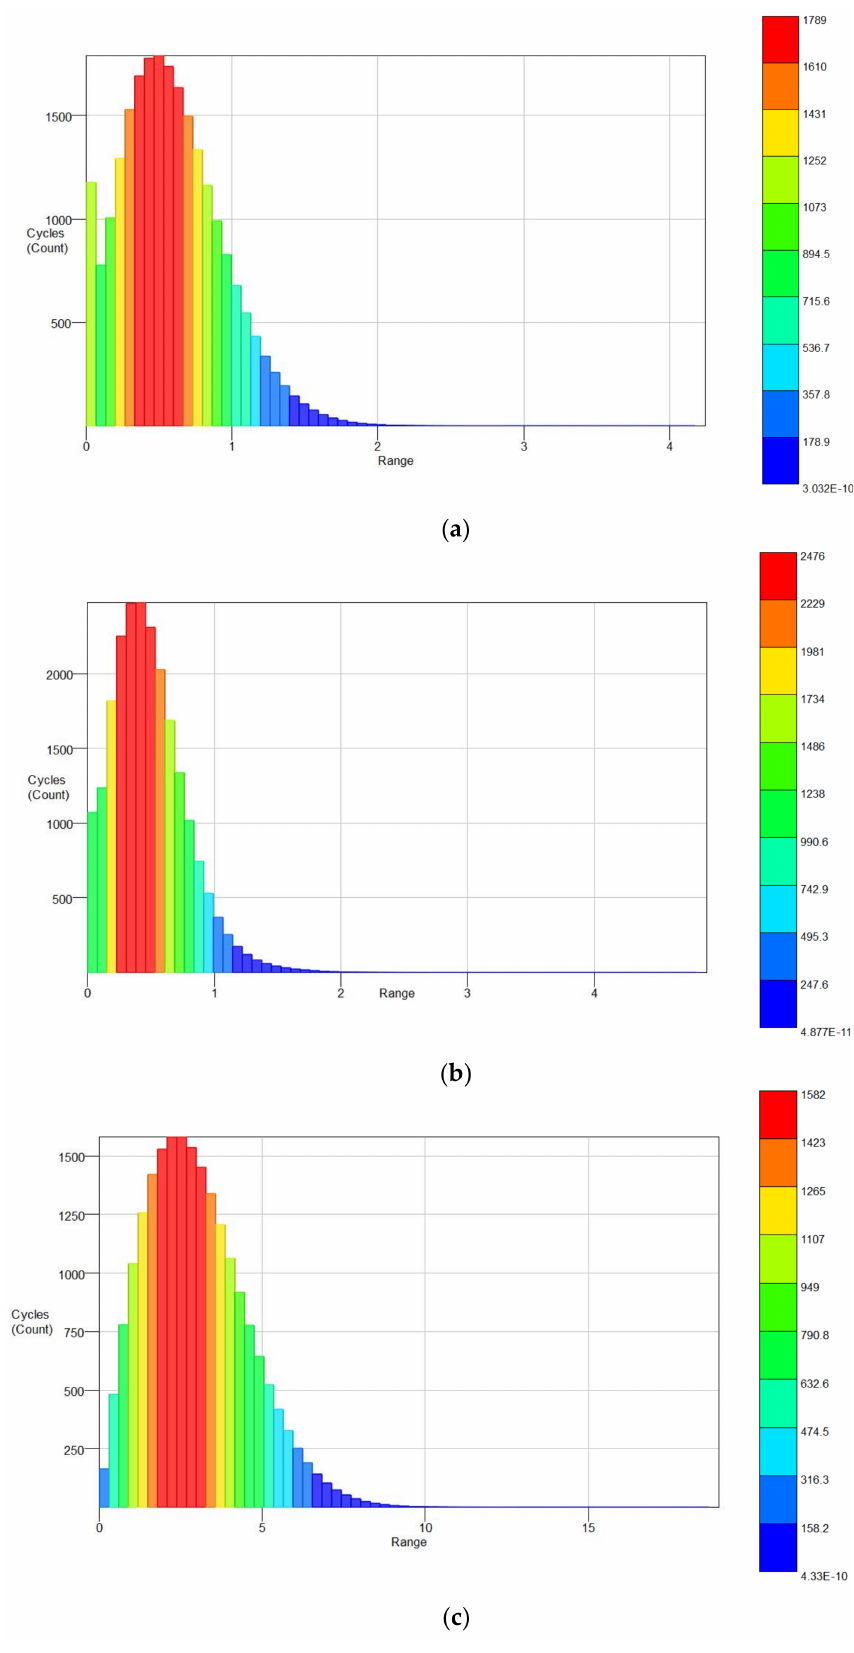
Figure 9. Dirlik PSD cycle count for different roads: ( a ) highway; ( b ) residential; and, ( c )